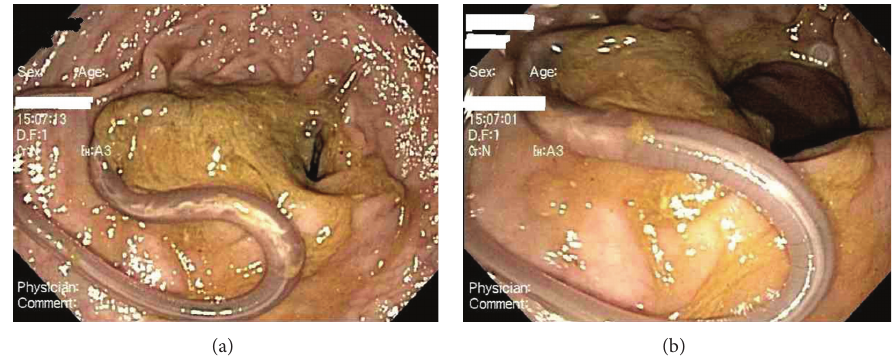
Figure 1: (a) A. lumbricoides seen during routine colonoscopy. (b) A. lumbricoides seen during routine colonoscopy.